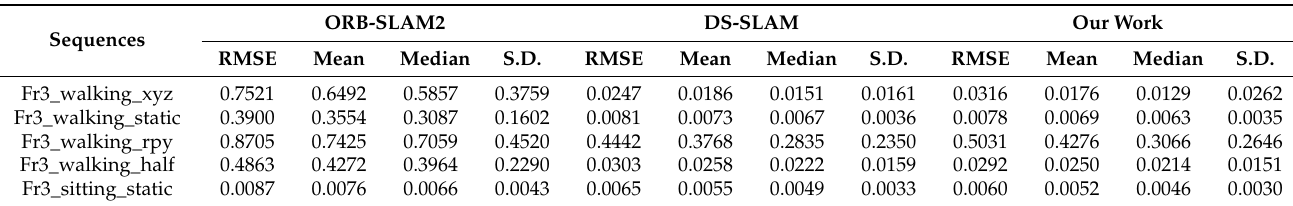
Table 4. The results of metric absolute trajectory error (ATE).